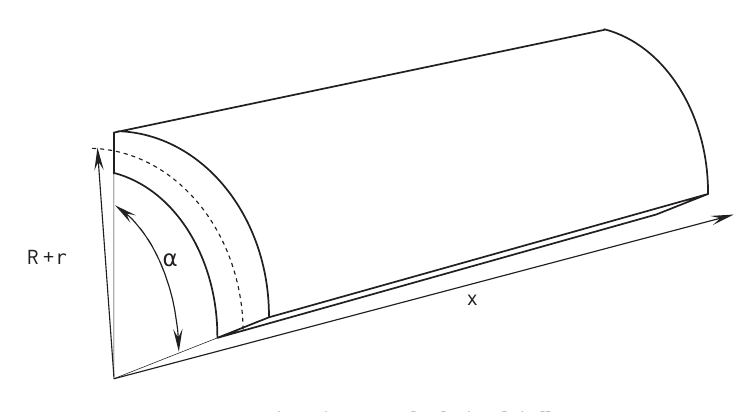
Fig. 1. Three-dimensional cylindrical